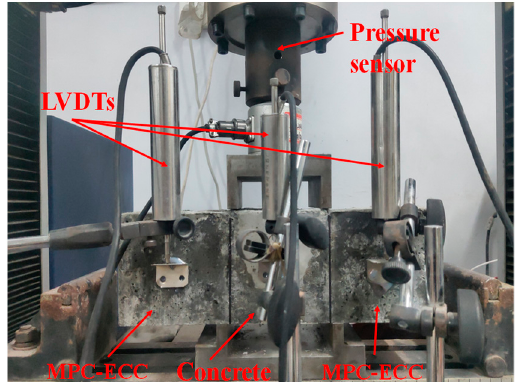
Figure 4. Setup of the double shear bond strength test.